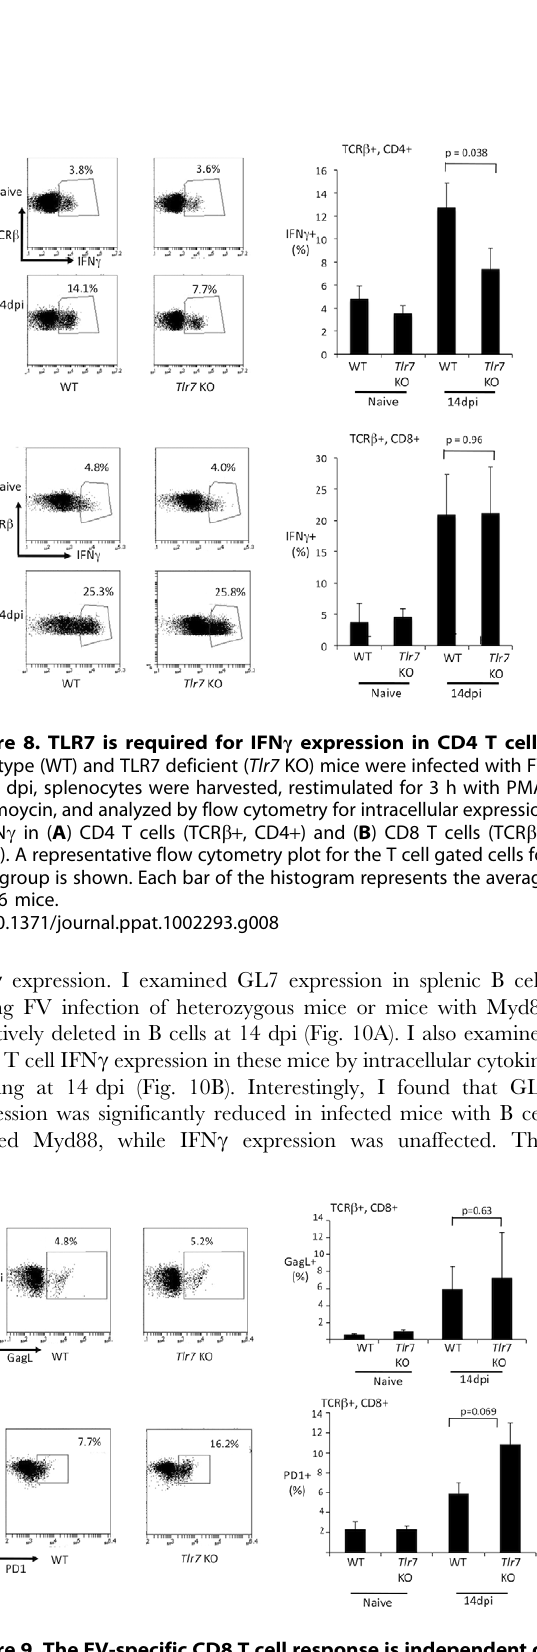
Figure 9. The FV-specific CD8 T cell response is independent of TLR7. Wild-type (WT) or TLR7 deficient mice ( Tlr7 KO) were infected with FV. At 14 dpi, splenocyte suspensions were analyzed by flow cytometry with an H2D b -GagL tetramer ( A ), or with an antibody to detect PD1 expression ( B ). Flow cytometry plots are gated on TCR b + , CD8 + T cells. Each bar of the histogram represents the average of 5–6 mice.